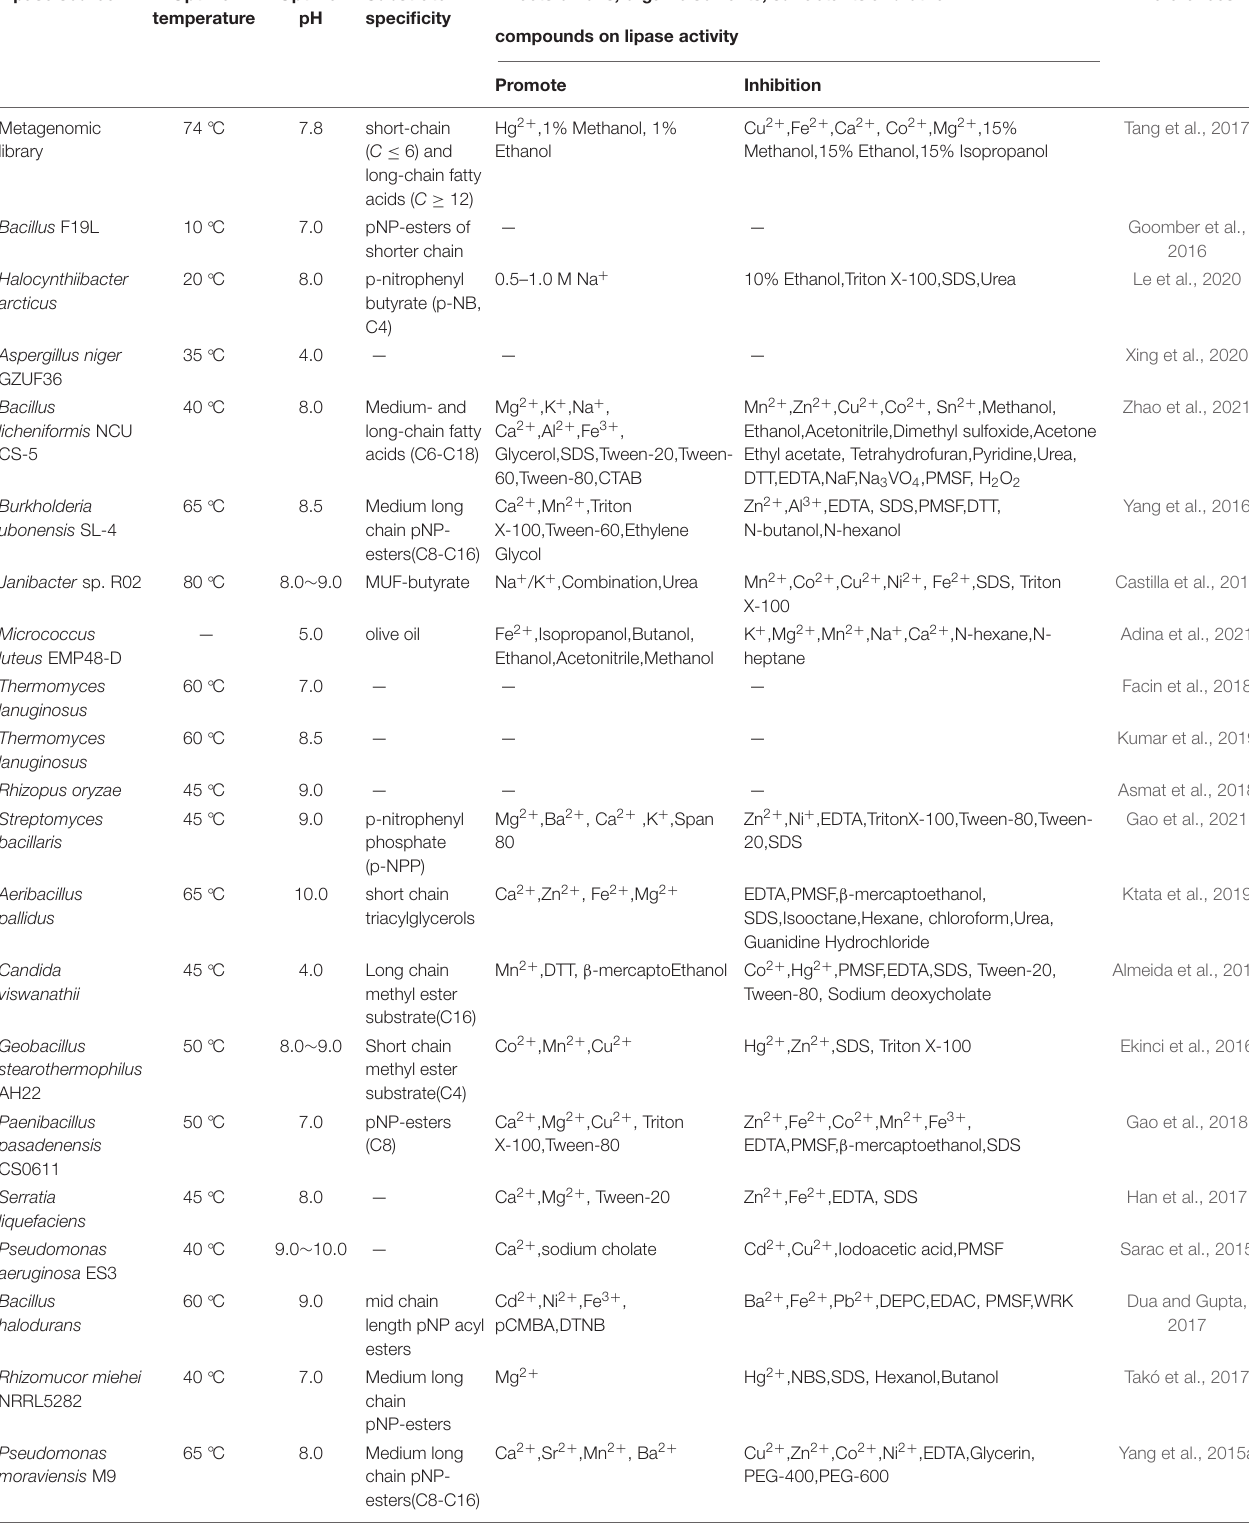
TABLE 1 | Some enzymatic properties of microbial